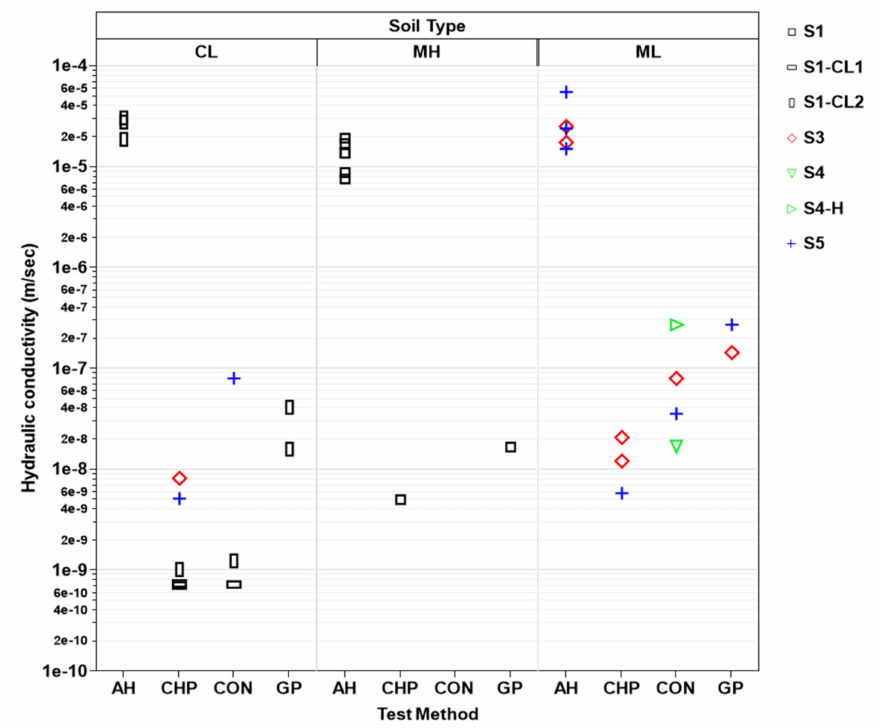
Figure 9. Hydraulic conductivity measured by different methods (AH = auger hole, CHP = constant head permeability, CON = consolidation test, GP = Guelph